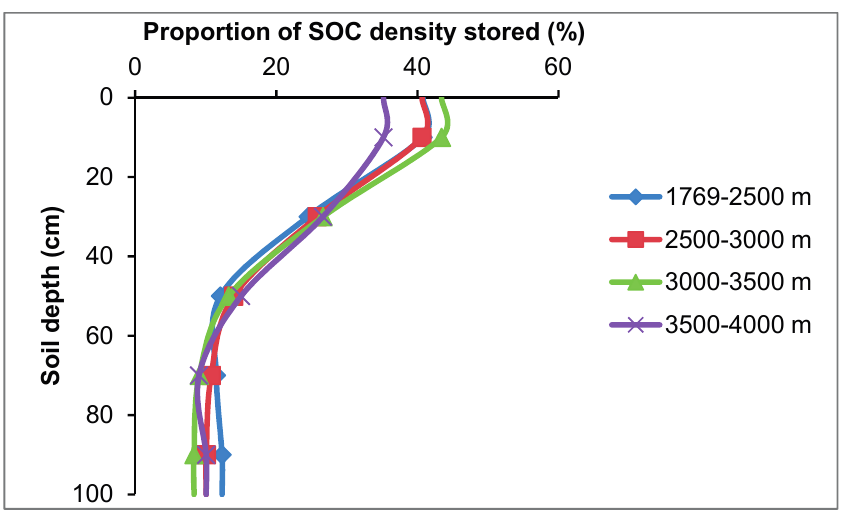
Figure 3. Proportion of SOC density (kg·m − 2 ) stored at different depths under different altitudinal zones. Data are in percentages and are plotted at the midpoint of each depth